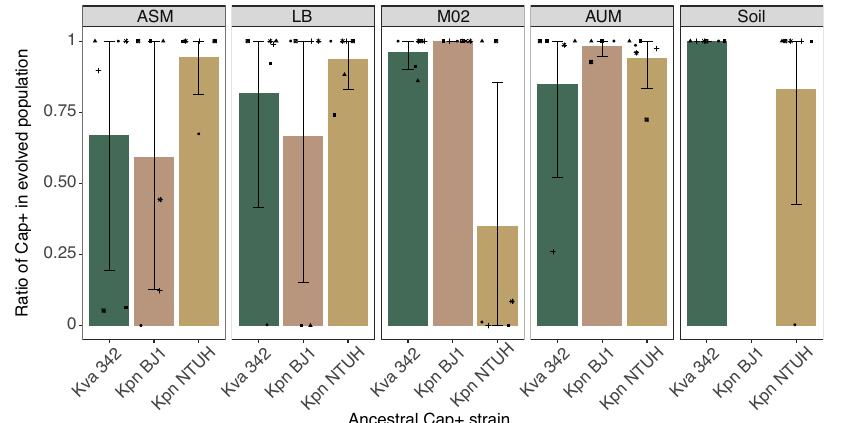
bars indicate a 95% interval of con fi dence. Source data are provided as a Source Data fi le.